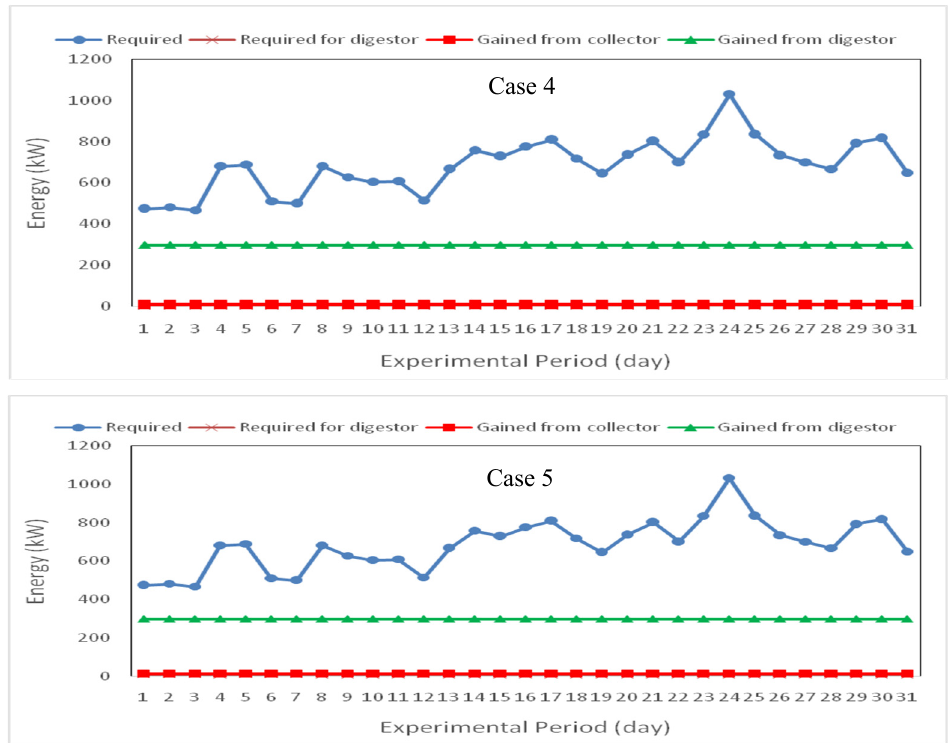
Figure 11. Energy requirement for cooling and energy gained by solar collector and biogas digester for different bio-solar house during summer season. Case 1. Heating the house with solar energy; Case 2. Heating the house and the biogas digester with solar energy during daylight and with biogas at night (temperature of the biogas digester is 309.15 K and retention time is 35 days); Case 3. Heating the house and biogas digester with solar energy during daylight and with biogas at night (temperature of biogas digester is 322.15 K and retention time is 17.5 days); Case 4. Heating the house with biogas while the biogas digester is heated by solar energy (temperature of biogas digester is 309.15 K and retention time is 35 days); Case 5. Heating the house with biogas while the biogas digester is heated by solar energy